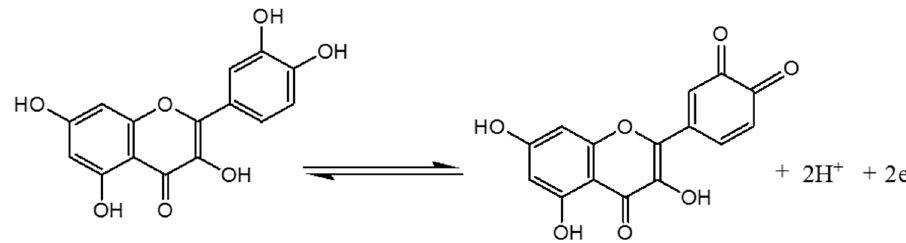
Scheme 2. The proposed electrochemical redox reaction of quercetin.